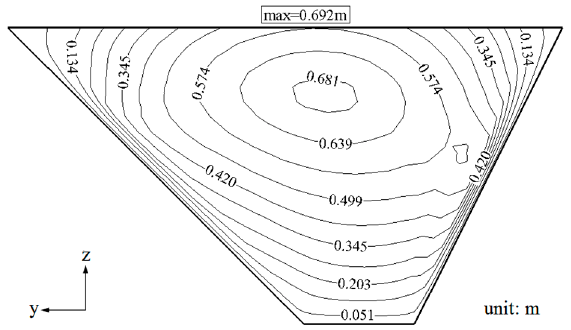
Figure 28. Flexural deformation contours of CACC ( k = 0.85 × 10 − 3 ).